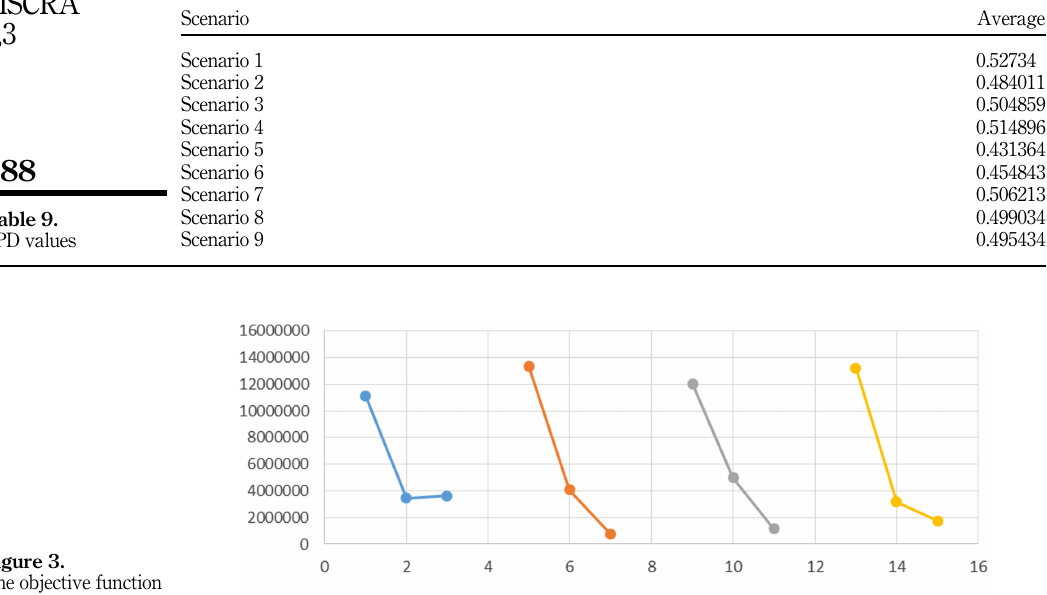
Figure 3. The objective function